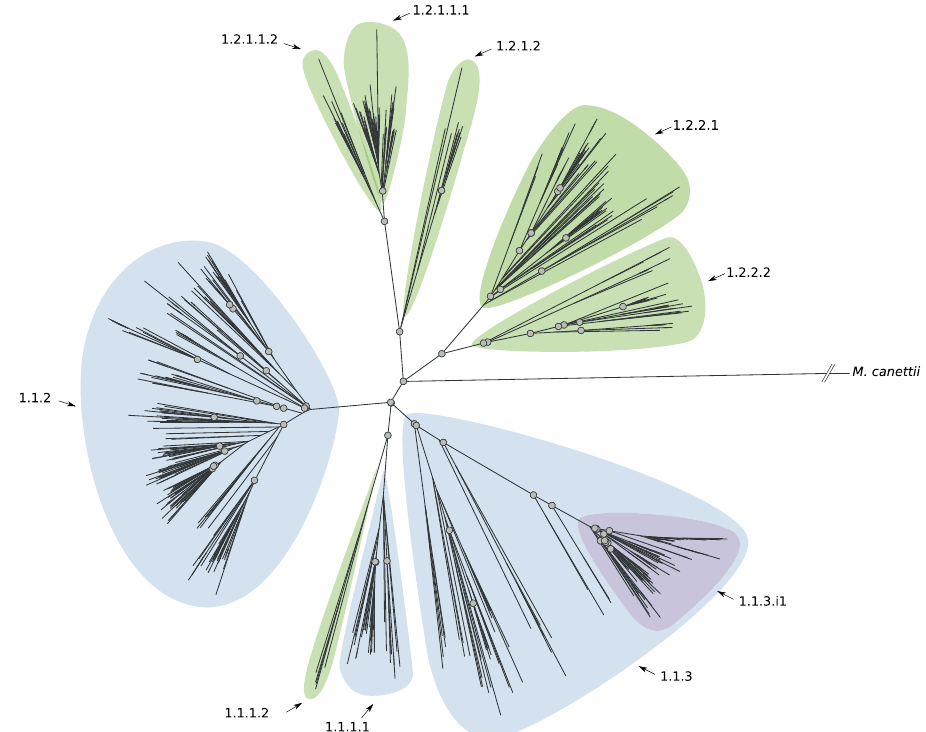
Fig. 1 Phylogenetic tree reconstruction of lineage 1 (binary tree). Gray circles de fi ne splits where the F ST ( fi xation index) calculated using the descendants of the two children nodes is greater than 0.33. The sub-lineages are de fi ned by colored areas (blue: sub-lineages already described in the literature; green: sub-lineages described here; purple: internal sub-lineages). Source data are provided as a Source Data fi